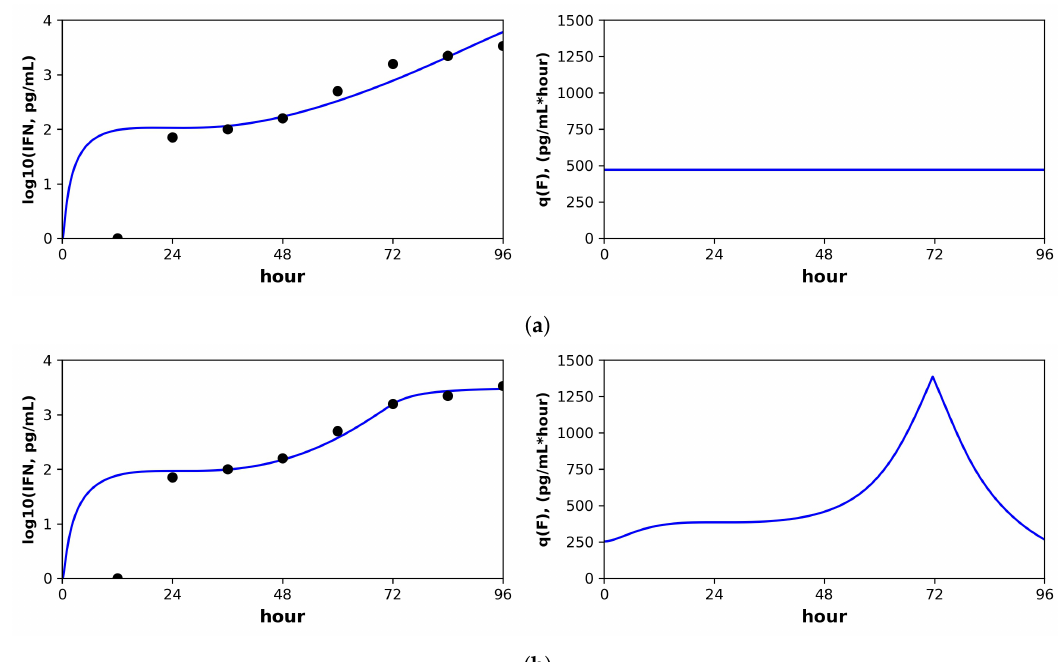
Figure 6. Constant versus pulsed rate secretion model predictions of interferon dynamics for the mutant (MT) dataset of Schmid et al. Shown are the predicted (blue curve) and sampled (black dots) IFN concentration dynamics (left panels) and the predicted IFN secretion rate dynamics (right panels) under our best fit model assuming ( a ) constant secretion rate and ( b ) pulsed secretion rate. Parameter values are shown in Table 6. Fits to the complete Schimd et al. MT dataset are provided in the Supporting Information, see Figures S1 and